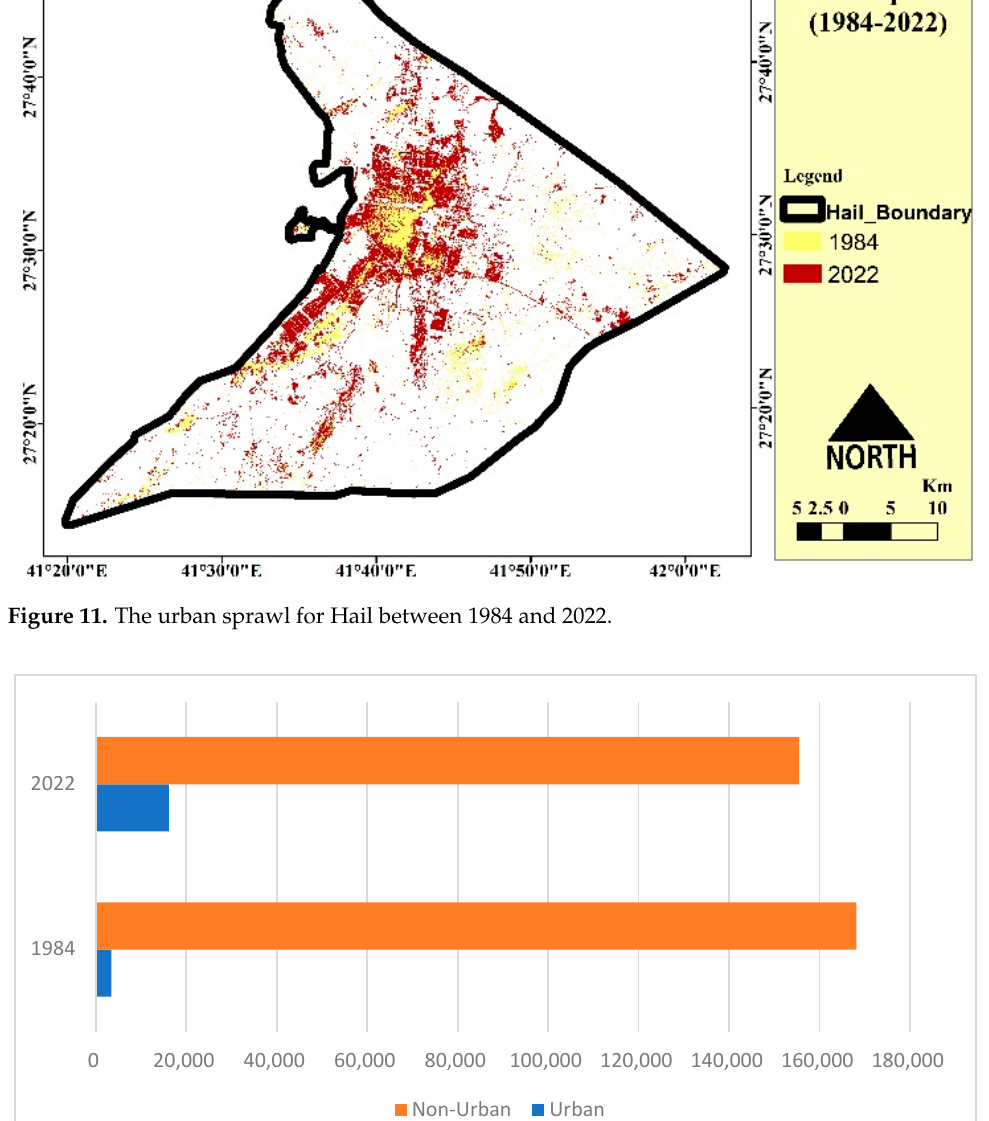
Figure 12. Urban area for Hail between 1984 and 2022.